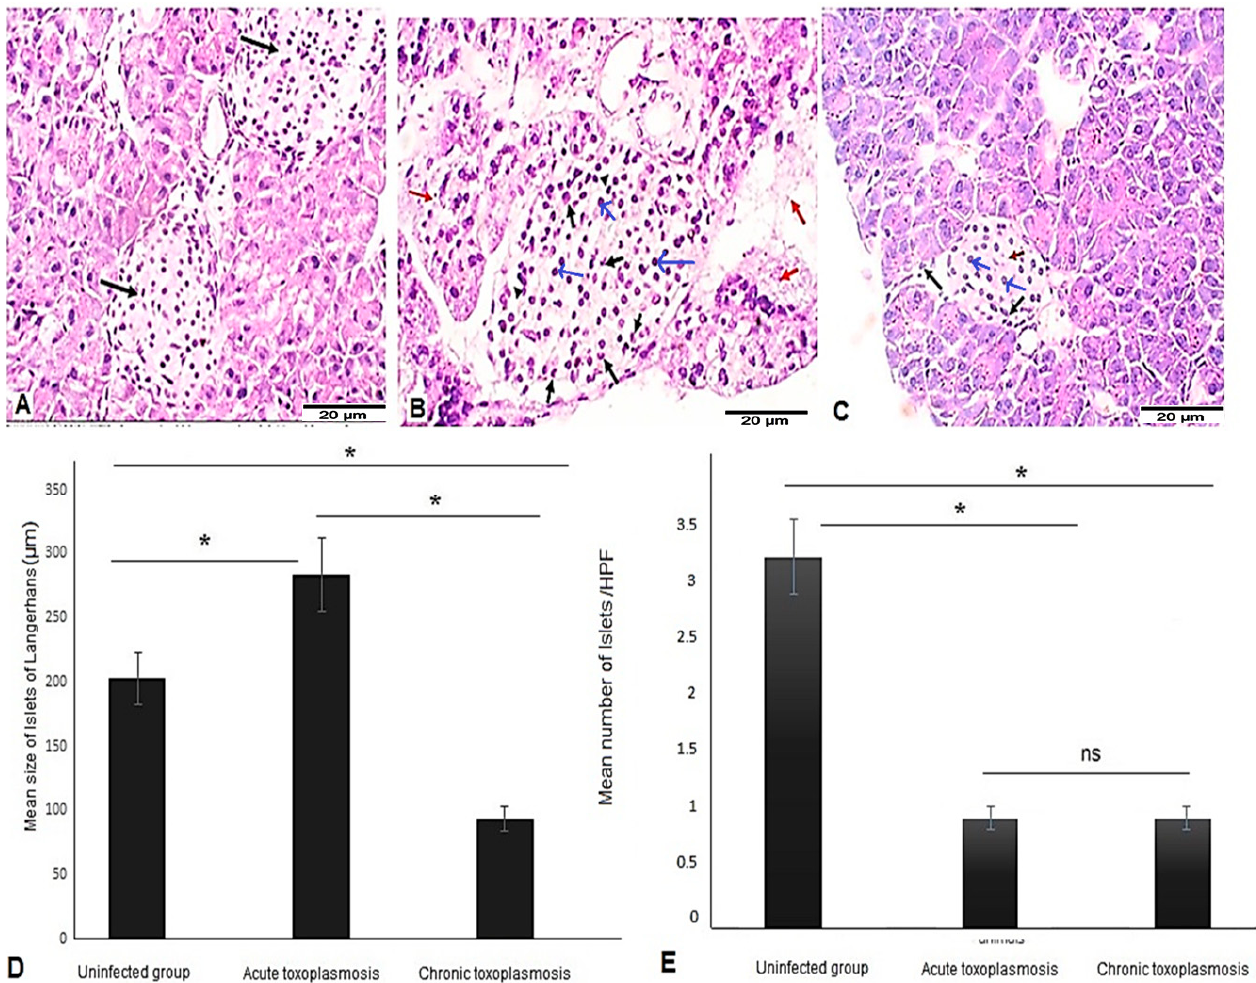
Figure 1. Acute and chronic toxoplasmosis are associated with pancreatic pathological changes and reduced the numbers of islets of Langerhans. Pancreatic tissue sections of mice from different groups ( n = 10/group) were stained with H & E stain and imaged at 400 × . ( A ) Representative image of pancreatic tissue sections of uninfected mice showing uniform rounded islets (black arrows) within pancreatic acini, with no inflammation, edema or necrosis. ( B ) Representative image of pancreatic tissue sections from the acute toxoplasmosis group showing enlarged islets of Langerhans with β cells (blue arrows), acute inflammatory infiltrate (black arrows), edema (arrow heads), and areas of necrosis (red arrows). ( C ) Representative image of pancreatic tissue sections from the chronic toxoplasmosis group showing significant reduction in size of the islets of Langerhans with β cells (blue arrows), mild infiltration by chronic inflammatory cells (black arrows) and areas showing fibrous-like material (red arrow). ( D ) Size of islets of Langerhans in uninfected, acute, and chronic toxoplasmosis mice groups. ( E ) Number of islets of Langerhans in uninfected, acute, and chronic toxoplasmosis mice groups/HPF. Data are expressed as mean ± SD ( n = 10). Asterisks (*) indicate a statistically significant difference; p < 0.05 and “ns” indicates insignificant difference. into islets of Langerhans. Our results showed that uninfected (Figure 2A) and acute toxo-